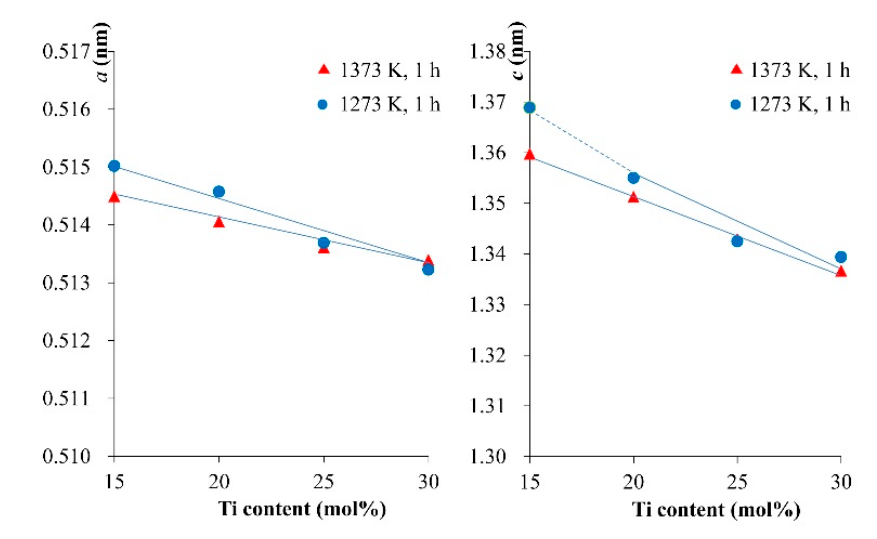
Figure 9. Relationship between lattice constants and Ti content.